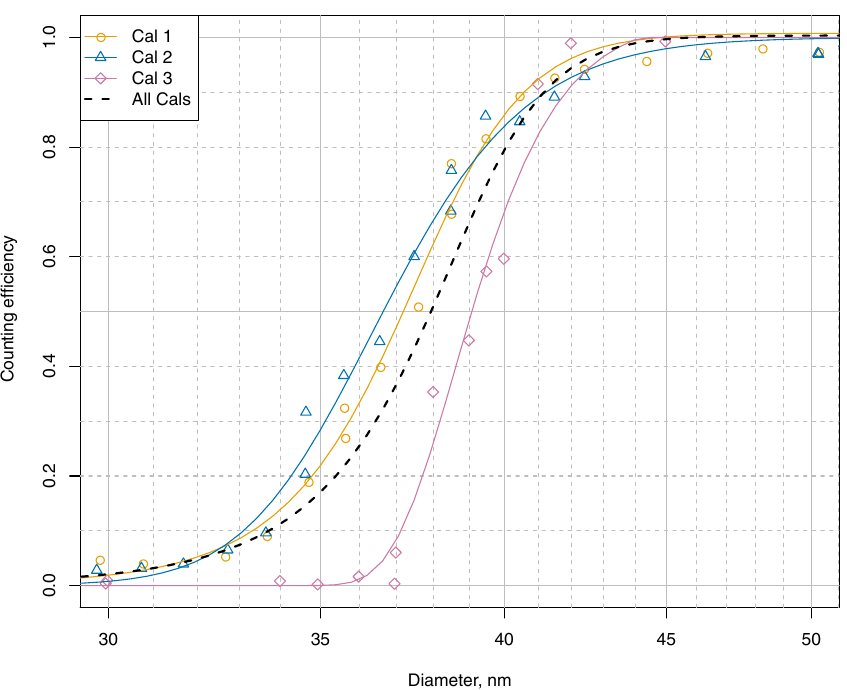
Figure 8. Calibrations of NMASS 2 channel 5 in detail. Calibrations on three separate days are shown with fitted logistic functions to guide the eye. This shows instabilities in the supersaturation of the condenser of this channel, with the 50% diameter varying between 36.5 and 39.1nm. The black dotted line shows the fit to all data, which is used for inverting the NMASS data. Table 2. Three-mode lognormal descriptions of representative aerosol size distribution cases giving model number concentration N ,